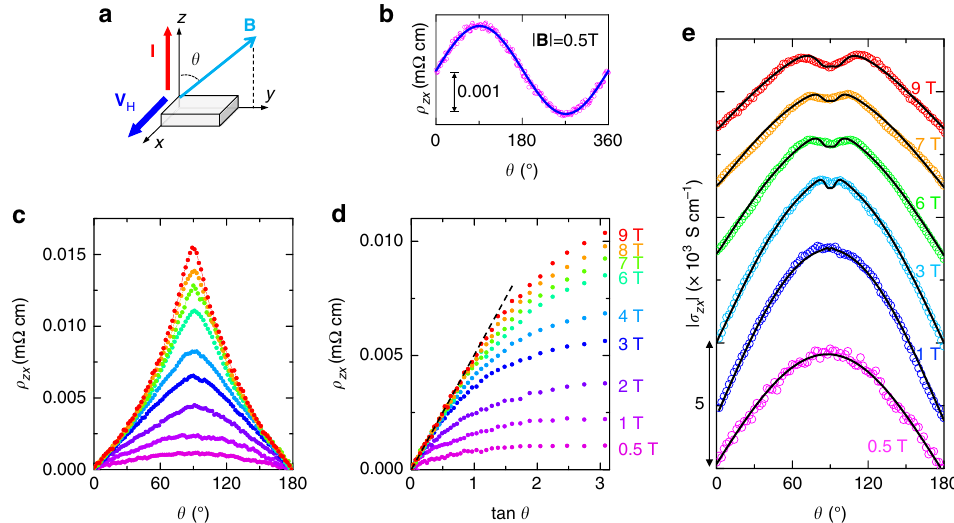
Fig. 3 Interlayer Hall effect for YbMnBi 2 . a Experimental setup for Hall effect measurements. b Angular dependence of Hall resistivity ρ zx at B = 0.5 T and T = 2 K, which follows a sin θ dependence as indicated by the fi tted solid curve . c Angular dependence of ρ against tan θ ; the tan θ asymptote (i.e., the dashed line ) can be observed at low angles. e Angular dependence of Hall conductivity σ zx at T = 2 K under different magnetic fi elds (the conversion process from the measured resistivity tensor elements to σ zx is shown in Methods). The data at different fi elds have been shifted for clarity. The solid lines represent the fi ts by Eq.